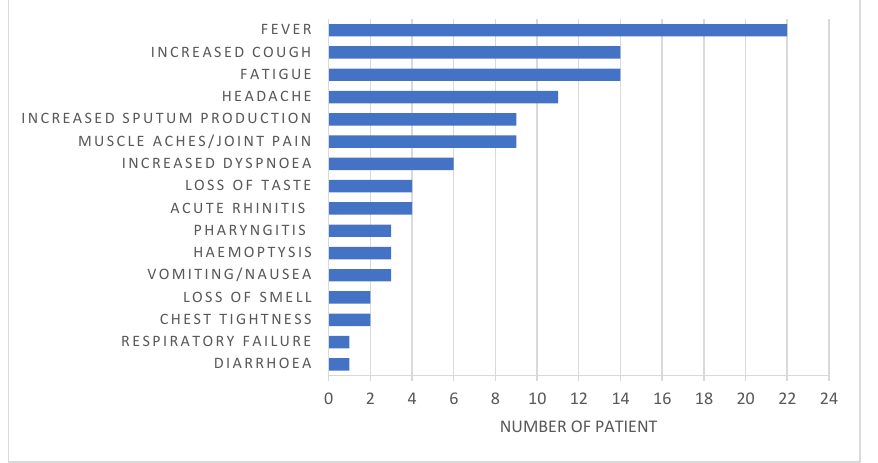
Figure 3. Distribution of the main symptoms at SARS-CoV-2 infection at onset in the patients with cystic fibrosis. Among the 31 patients, 28 (90%) had symptoms of SARS-CoV-2 infection at onset, whereas 3 (10%) remained asymptomatic.